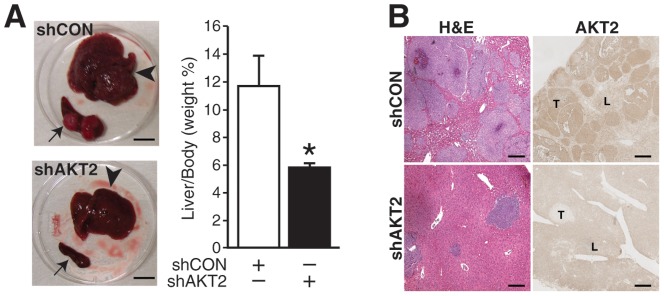
AKT2 modulated neuroblastoma liver metastasis.(A) Representative photographs of splenic primary tumors (arrows) and liver metastases (arrowheads) from mice injected with BE(2)-C/shCON and BE(2)-C/shAKT2 cells. Liver metastases were fewer in mice injected with BE(2)-C/shAKT2 cells (bottom). Bar scale is 10 mm. Bar graph represents the quantitative analysis of liver weight relative to mice body weight (* = p<0.05 vs. shCON). (B) Representative H&E-stained liver sections from mice injected with BE(2)-C/shCON and BE(2)-C/shAKT2 (left panels). Immunohistochemical staining of AKT2 in liver sections from mice injected with BE(2)-C/shCON and BE(2)-C/shAKT2 cells (right panels). (“L” = liver, “T” = tumor; bar scale is 50 µm).